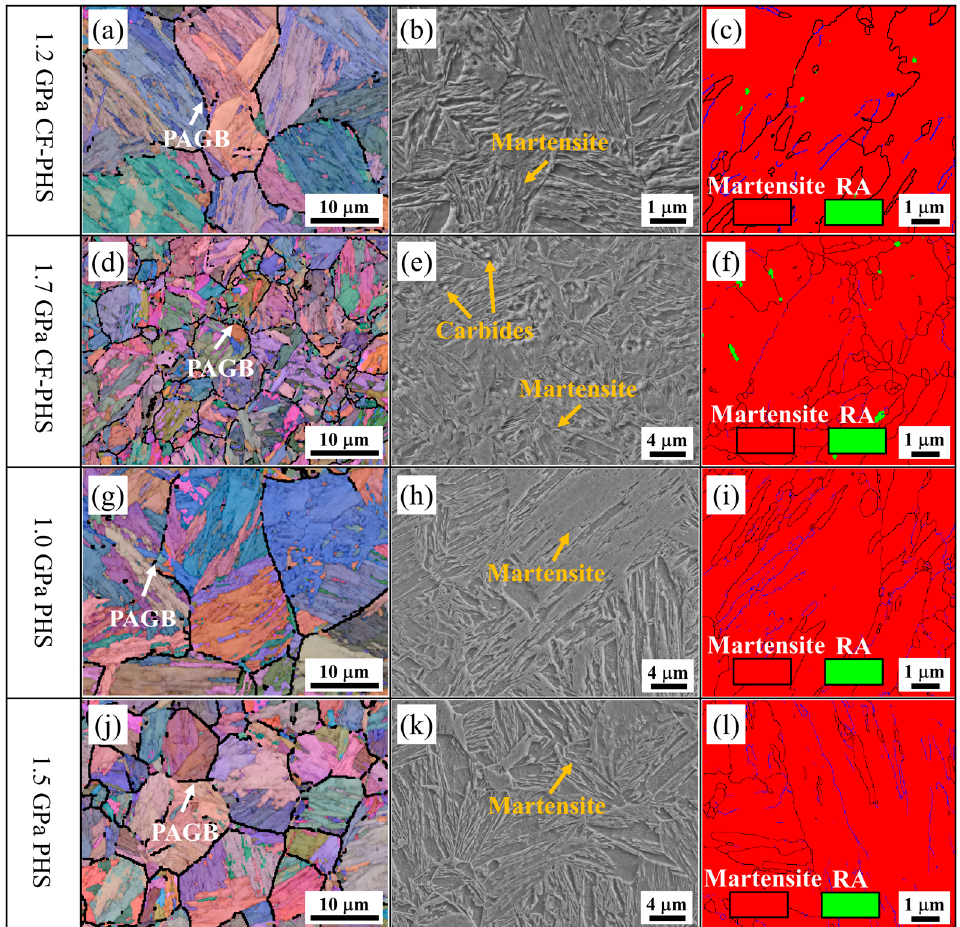
Figure 6. Grain size distribution and microstructure of the all PHSs. ( a , d ) PAGSs, ( b , e ) microstructure, ( c , f ) EBSD mappings of the 1.2 and 1.7 GPa CF-PHS, respectively. ( g , j ) PAGSs, ( h , k ) microstructure, ( i , l ) EBSD mappings of the 1.0 and 1.5 GPa Al-Si-coated PHS, respectively. RA and martensite were marked by green and red color, respectively.